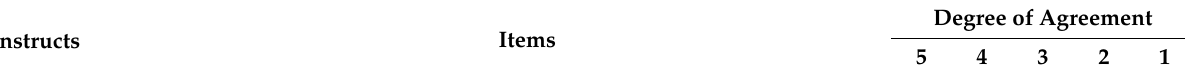
Table 2. List of questions included in the questionnaire survey conducted.